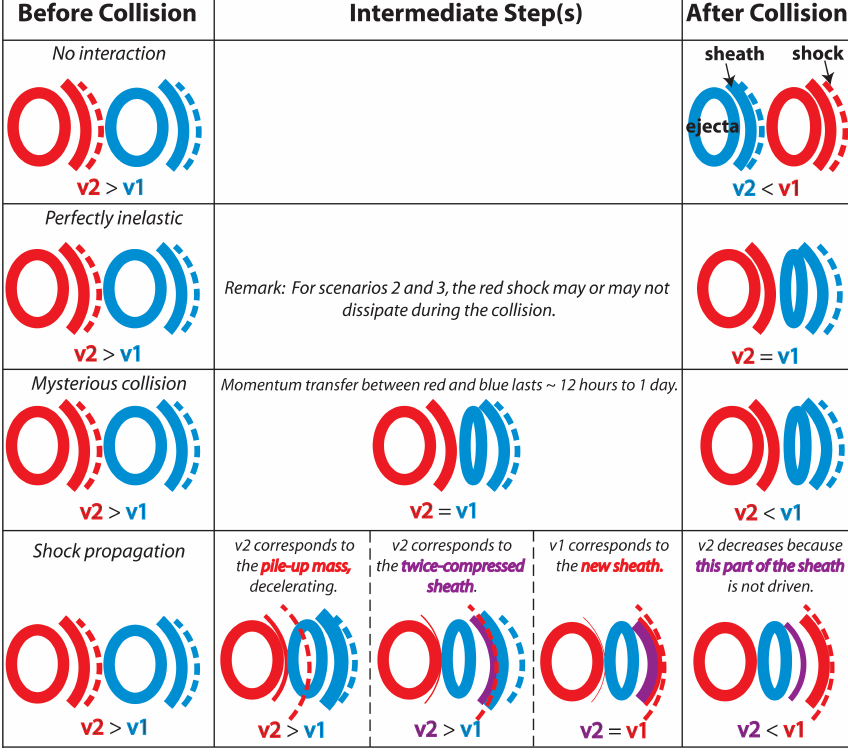
Fig. 4. The four scenarios for CME-CME collisions that might explain the fact that the first front after the collision is faster than the second front. In the sketches, the ellipses, the solid arcs, and the dashed arcs correspond to the ejecta, dense sheaths and to the shock waves,